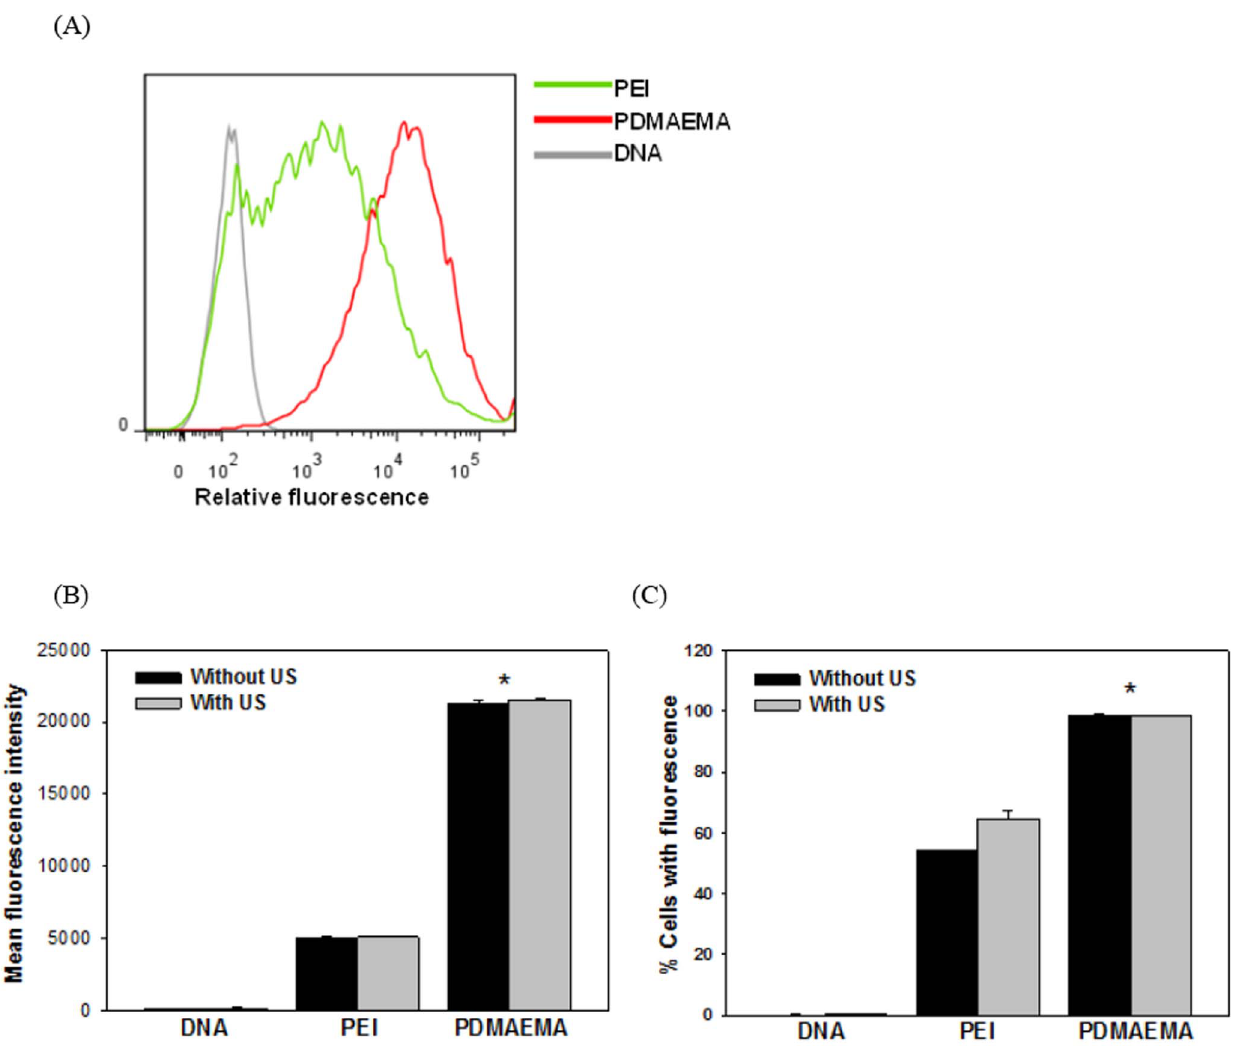
Figure 7. Effect of PEI and PDMAEMA on intracellular uptake of DNA monitored by flow cytometry 24 h following exposures. Fluorescence labeled DNA was mixed with PEI or PDMAEMA in culture cell plates before being treated with US. (B) The overall fluorescence intensities of cultured cells and (C) the percentage of cells with fluorescence are also shown. All results are expressed as the mean 6 SEM for four independent measurements. * P , 0.05 vs. PEI group (regardless of US